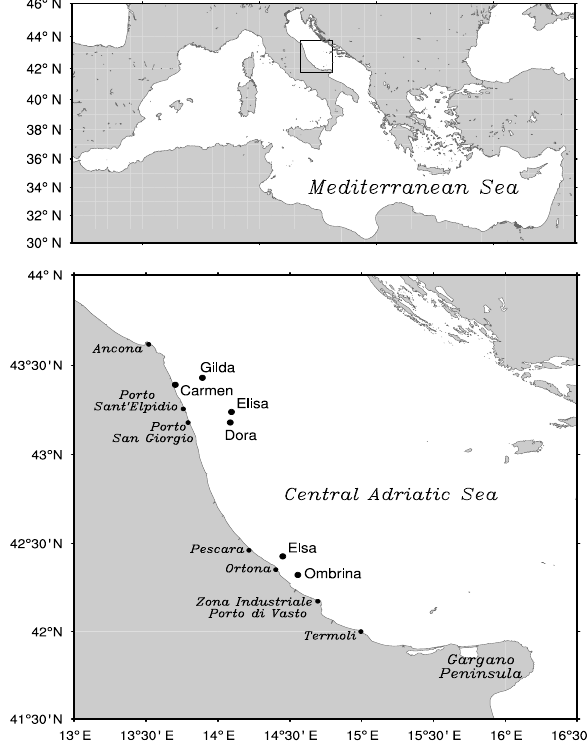
Figure 5. The Adriatic subdomain, where hazards from potential accidents on the oil platforms ( Gilda , Carmen , Elisa , Dora , Elsa , and Ombrina ) were